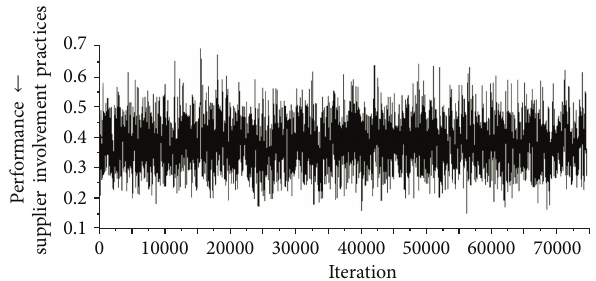
Figure 4: Shows the trace plot of supplier involvement practices → NPD project performance.